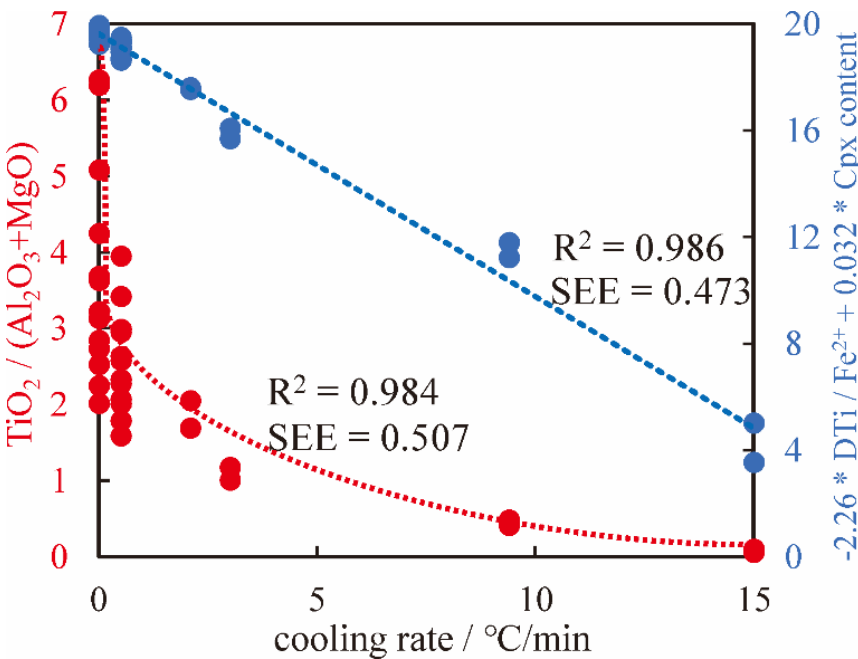
Figure 14. Comparison between Equation (2) [6] and Equation (3). Equation (3) yields the blue line, and Equation (2) yields the red curve. Equation (3) has a better fitting degree and smaller error ranges. Although the SEE in Equation (3) is slightly lower than that in Equation (2) [6], and the errors in Equation (3) mainly arise from a higher cooling rate, while the errors in Equation (2) [6] mainly arise from a lower cooling rate. Equation (3) may better predict the low cooling rate, which is more common in natural samples [5,87].